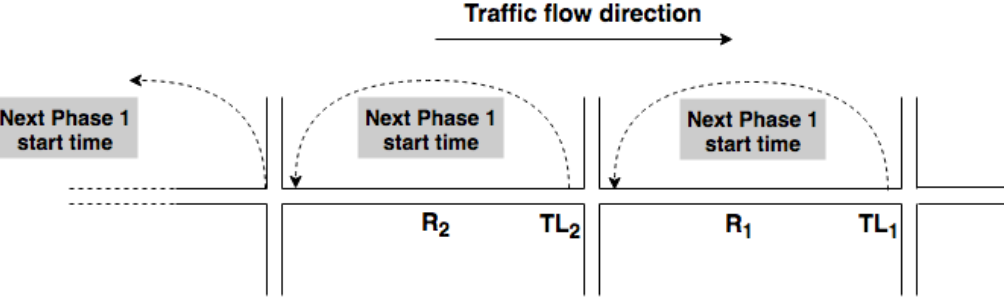
Figure 8. Multiple junctions synchronization